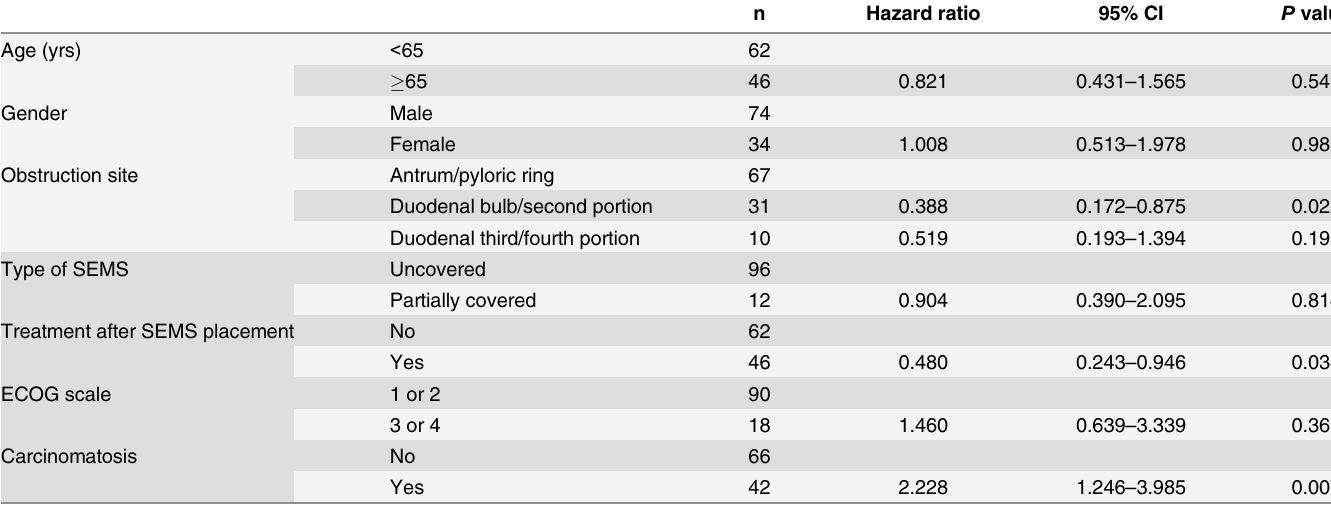
Table 4. Cox proportional-hazards model of obstructive symptom-free survival after self-expandable metallic stent